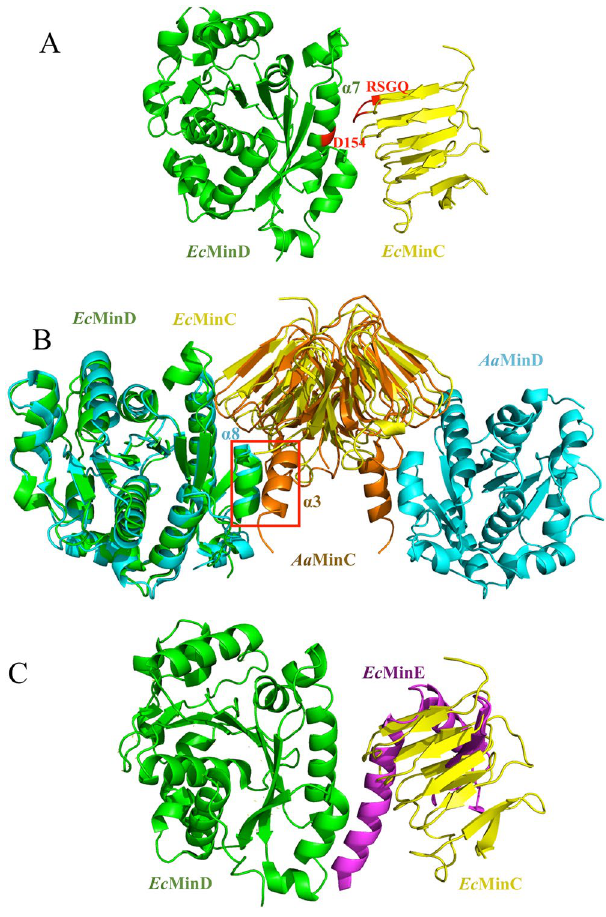
Figure 2. Structure of assembled Ec MinCD complex and its superimposition with Aa MinCD complex and Ec MinDE complex. ( A ) Assembled Ec MinCD complex using Ec MinC CTD and Ec MinD superimposed with Aa MinCD (green: Ec MinD, yellow: Ec MinC CTD ). The highly-conserved residues D154 in Ec MinD and RSGQ motif in Ec MinC are known to be critical for MinC-MinD interaction. ( B ) Superimposition of Ec MinCD with Aa MinCD (green: Ec MinD, yellow: Ec MinC CTD , blue: Aa MinD, orange: Aa MinC CTD ). Helix3 of Aa MinC CTD forms interface 2 with helix 8 of MinD, which is absent in Ec MinCD complex. ( C ) Superimposition of Ec MinCD with Ec MinDE (green: Ec MinD, yellow: Ec MinC CTD , magenta: Ec MinE). We observe that the MinE contact helix competes with MinC for binding to MinD and the interface surfaces clearly overlap 25, 26 , which provides explanation of why MinE can stimulate the release of